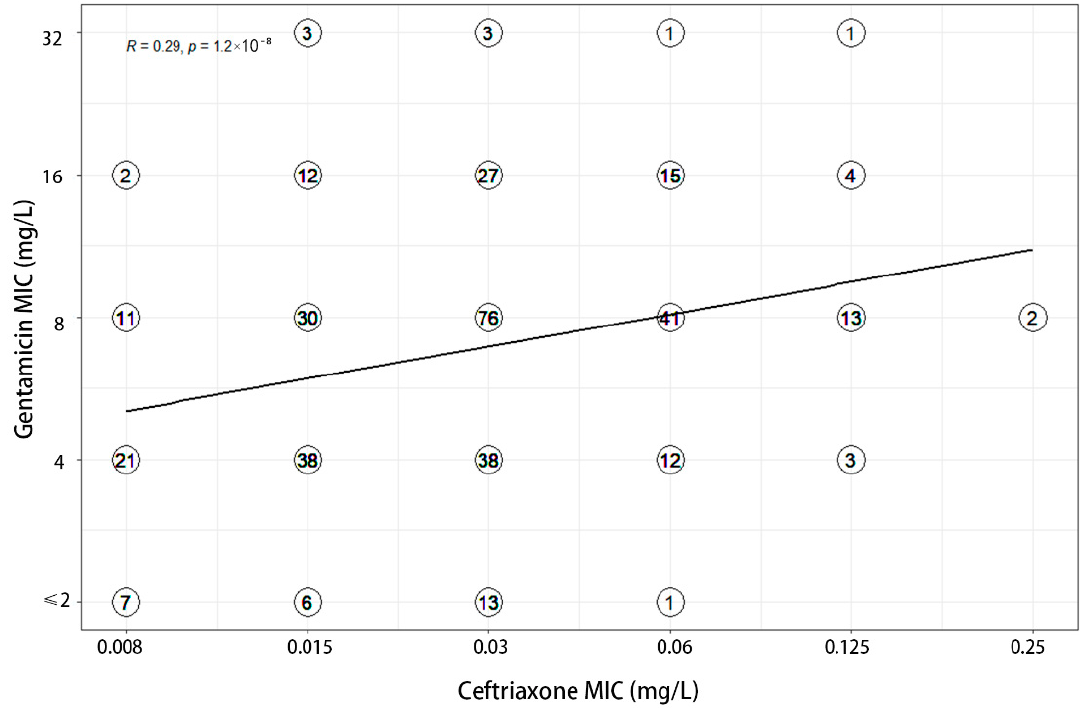
Figure 2. Correlation between MICs to gentamicin and ceftriaxone.